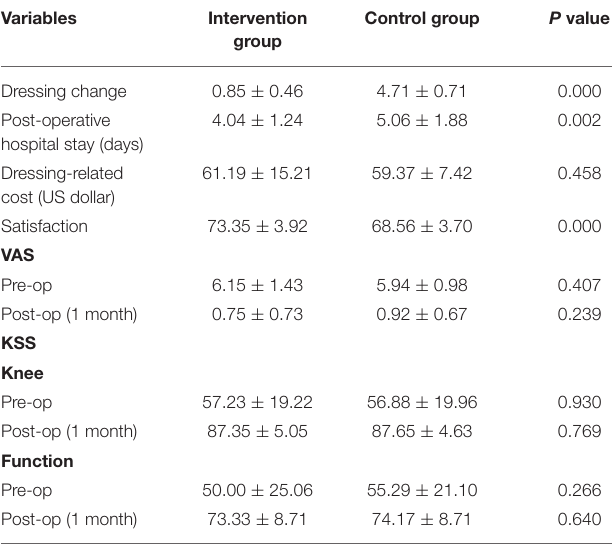
TABLE 3 | Comparisons of times of dressing changes, post-operative hospital stay, dressing-related cost, satisfaction, pain and function score between two groups.